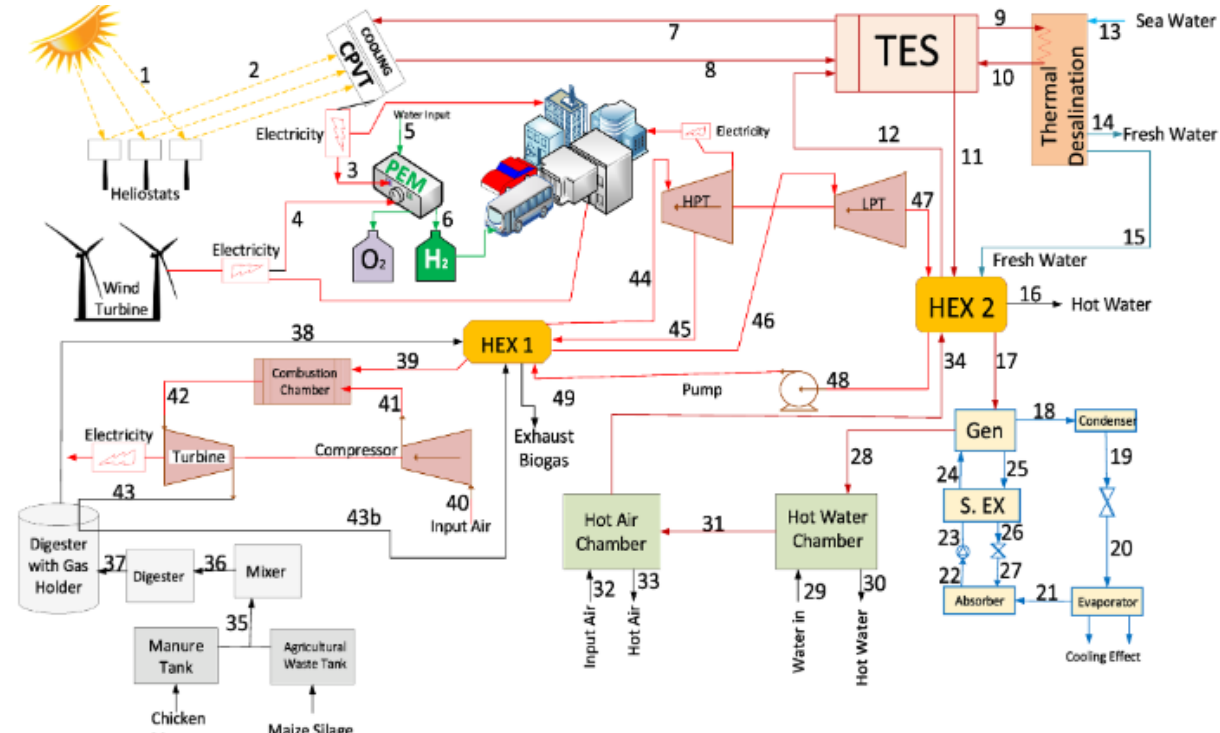
Figure 16. Multi-renewables energy system [197].